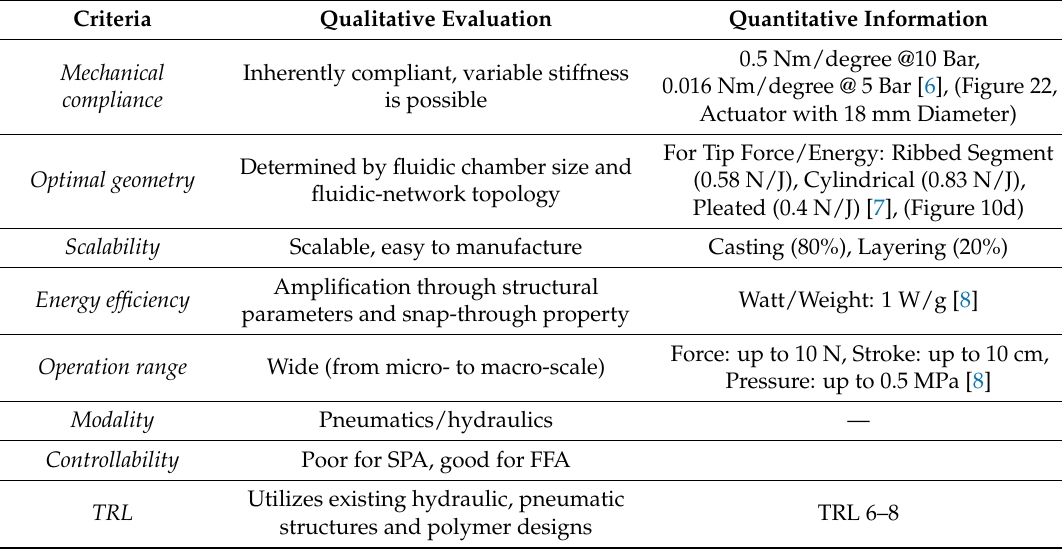
Table 1. Evaluation of FEA type for illustrative example of the review methodology. Criteria Qualitative